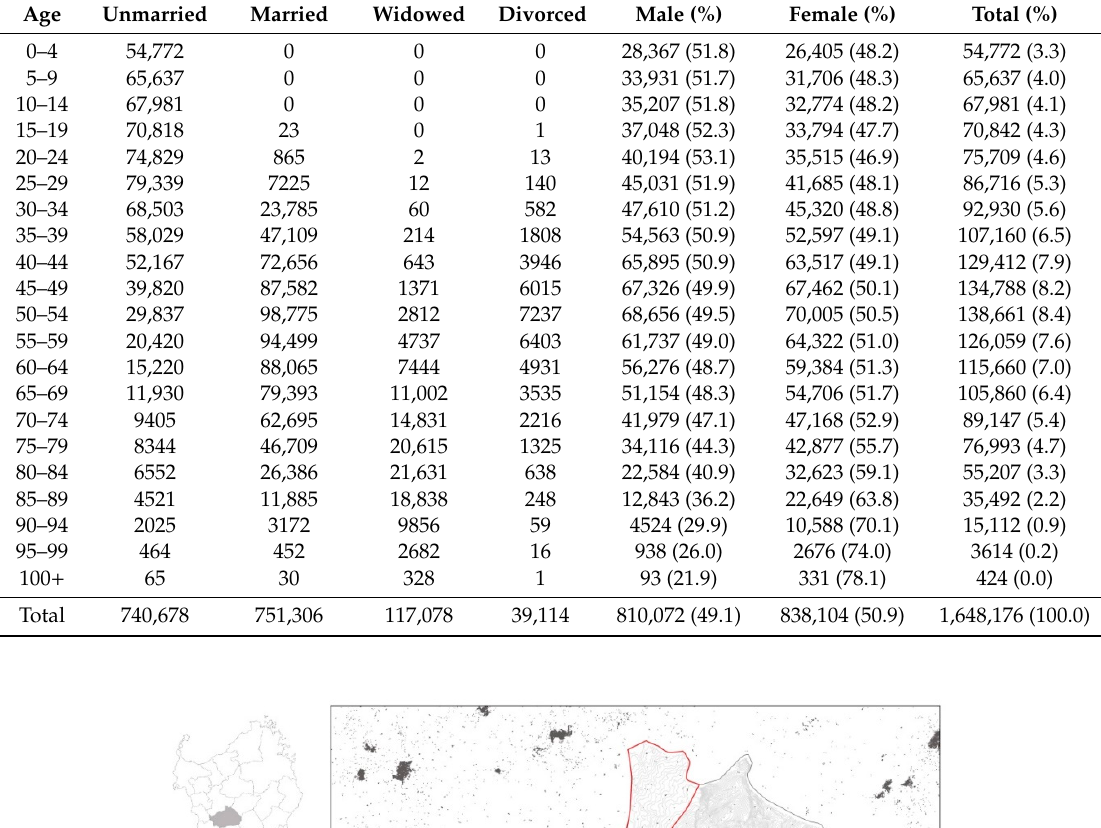
Table 1. Distribution of the Sardinian population (2018) by age, marital status, and gender [32].